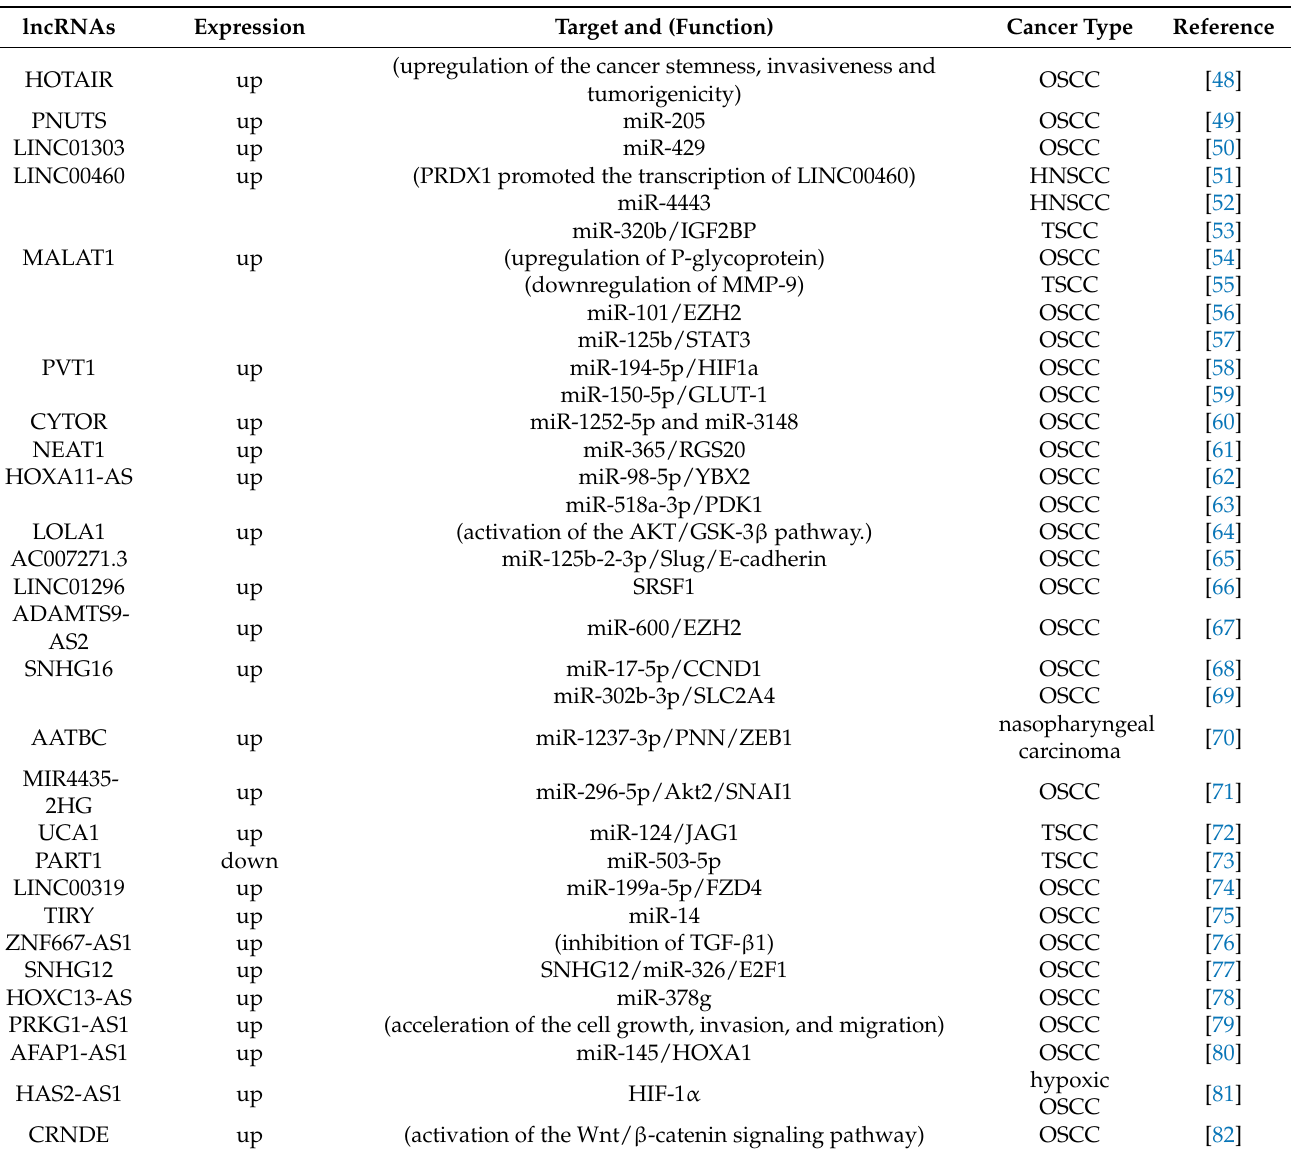
Table 1. EMT inducing lncRNAs in